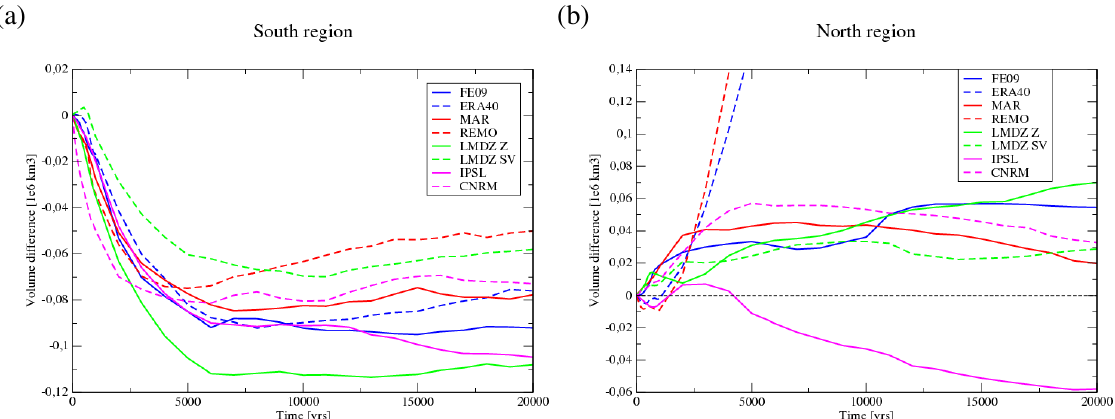
Fig. 11. Evolution of the difference between the experiment in which the surface elevation change feedback on temperature and precipitation is not taken into account, minus the standard correction experiment. On the left ( a ), the south region (latitudes lower than 68 ◦ N) and on the right ( b ), the north region (latitudes greater than 75 ◦ N).